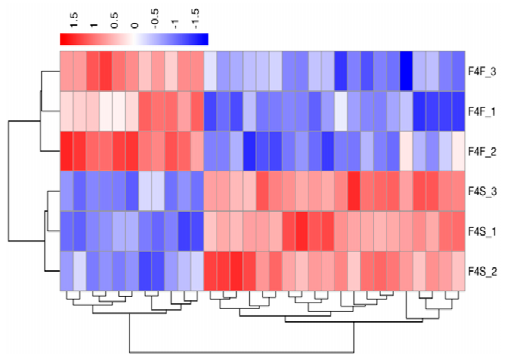
Figure 3. Overall FPKM (fragments per kilobase length from a gene per million fragments) hierarchical clustering map of the four-week-old males.